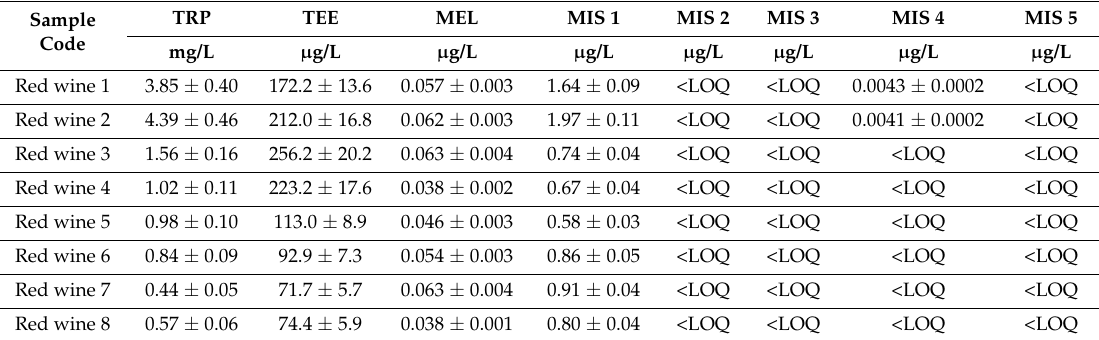
Table 4. Levels of TRP (tryptophan), TEE (tryptophan ethyl ester), MEL (melatonin), and MEL isomers (MISs) in red wine samples. Data are expressed as mean ± standard